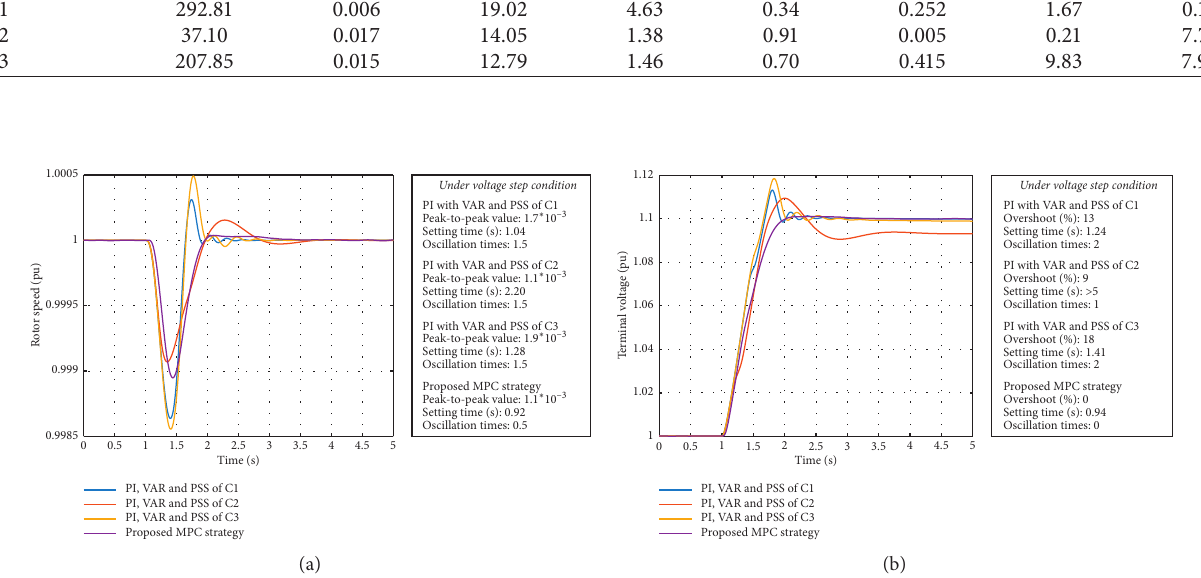
Figure 15: Response comparison under terminal voltage step condition. (a) Rotor speed response. (b) Terminal voltage